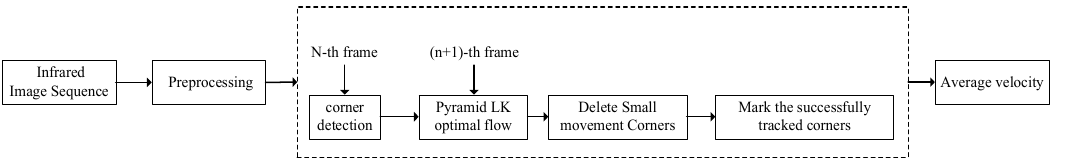
Figure 6. Crowd-motion estimate.